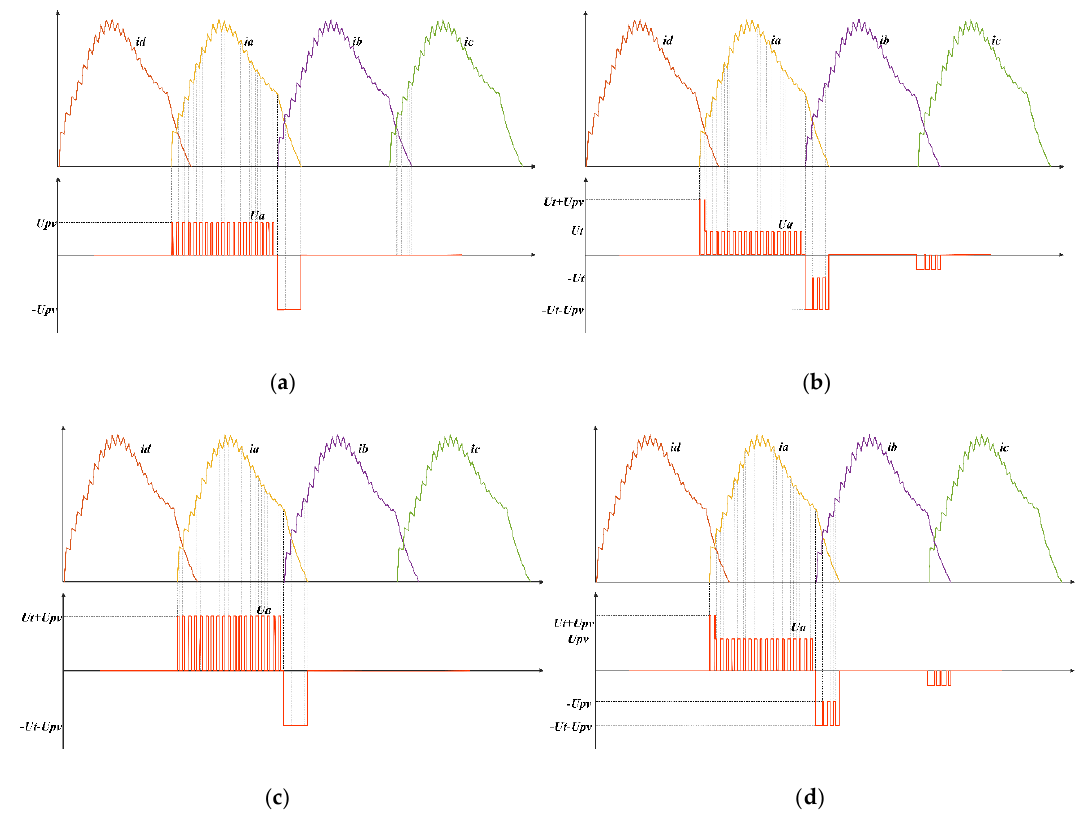
Figure 3. Relationship between phase current and phase voltage: ( a ) driving by asymmetric half-bridge topology (AHT), ( b ) powering by the battery pack, ( c ) powering by the PV panels and battery bank together, and ( d ) powering by the PV panels.